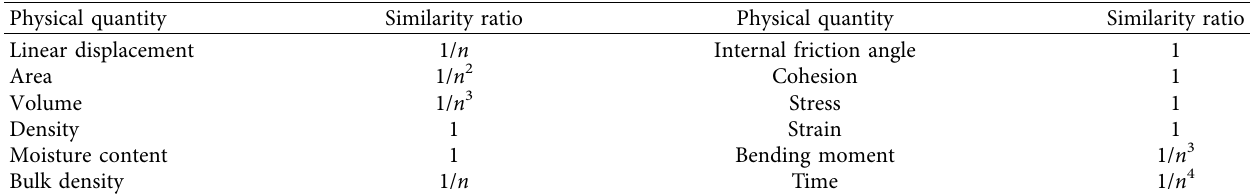
Table 3: Similarity ratios of the constant stress centrifugal model